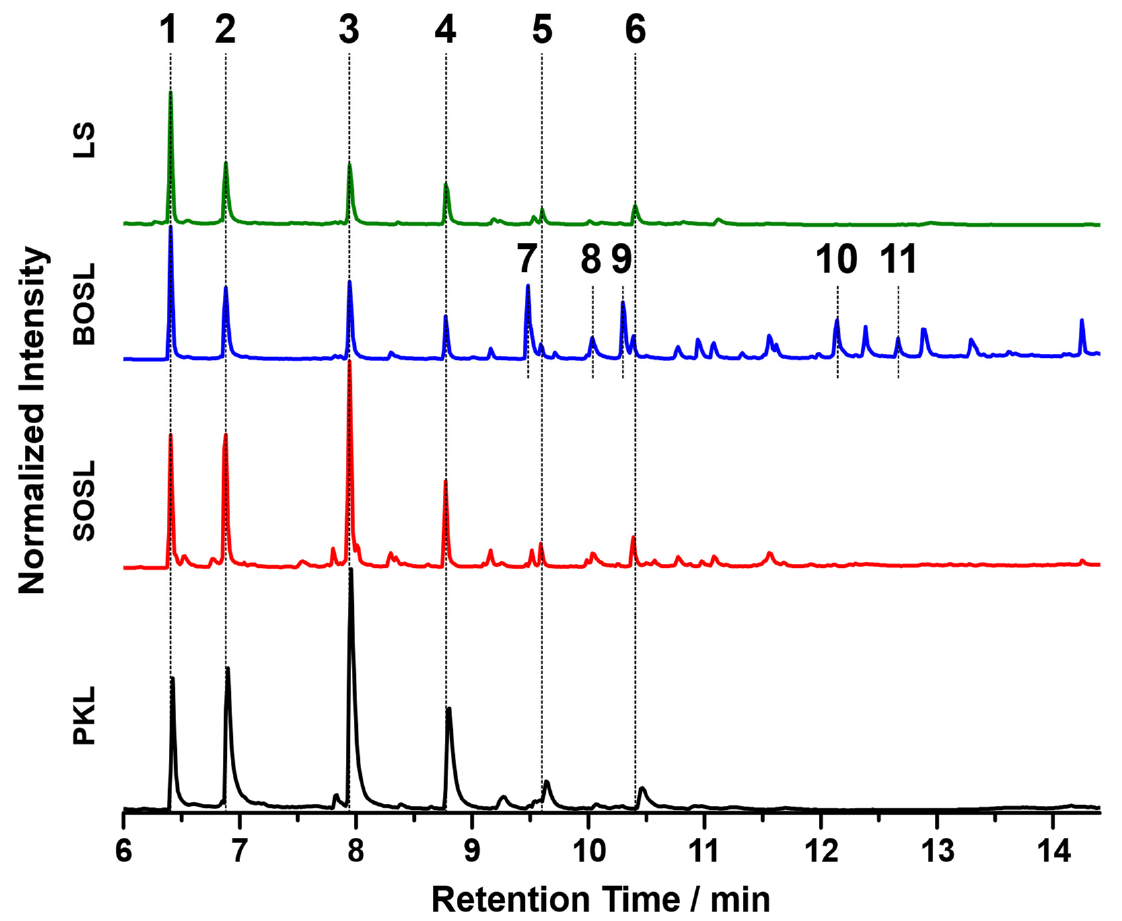
Figure 8. GC-MS chromatograms of the bio-oils won from the four technical lignins: PKL, SOSL, BOSL, and LS. The numbers in the figure refer to the proposed assignments in Table 3.